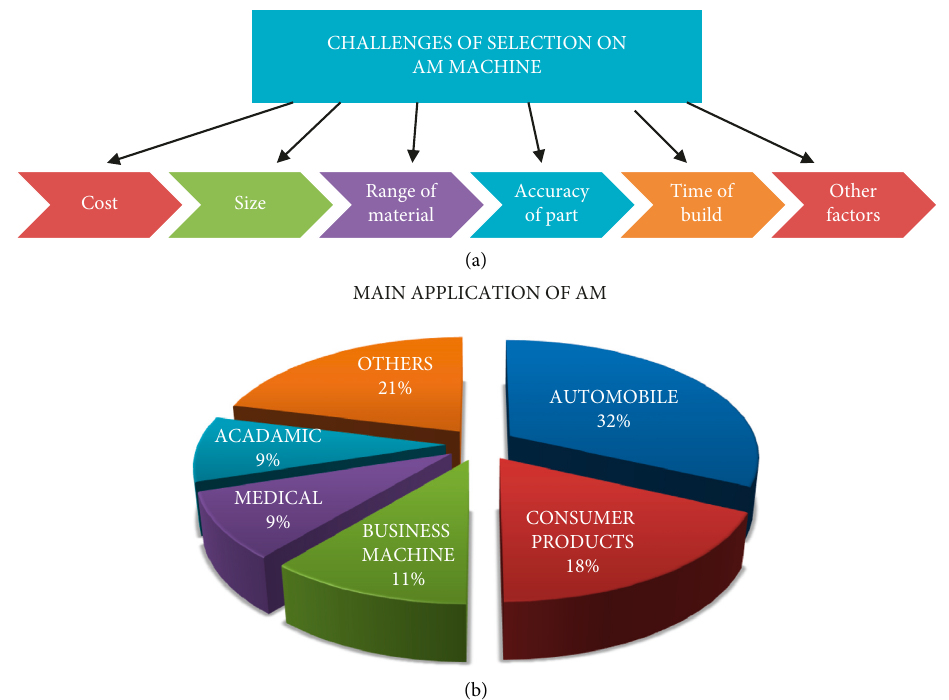
Figure 1: (a) Challenges of selection on AM Machine [3]. (b) Main application of AM in different fields [4, 5].